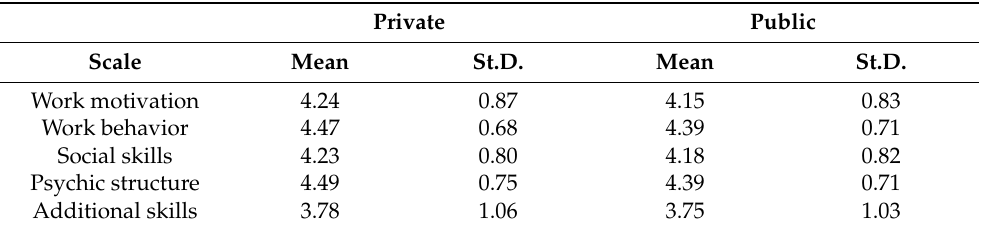
Table 19. Means and standard deviations (St.D.) of the overall answers of the different scales of the questionnaire when the sample is differentiated by the tenure of the university.